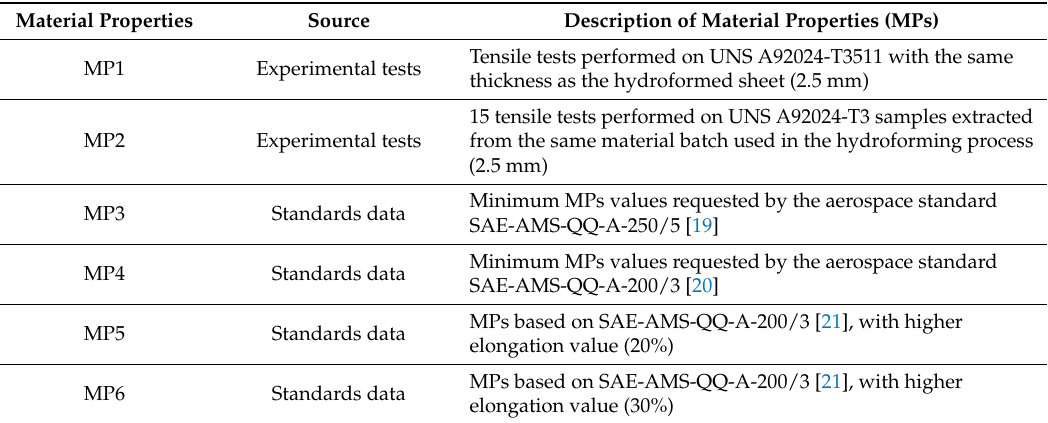
Table 2. Material Properties employed in hydroforming simulations of UNS A92024-T3.